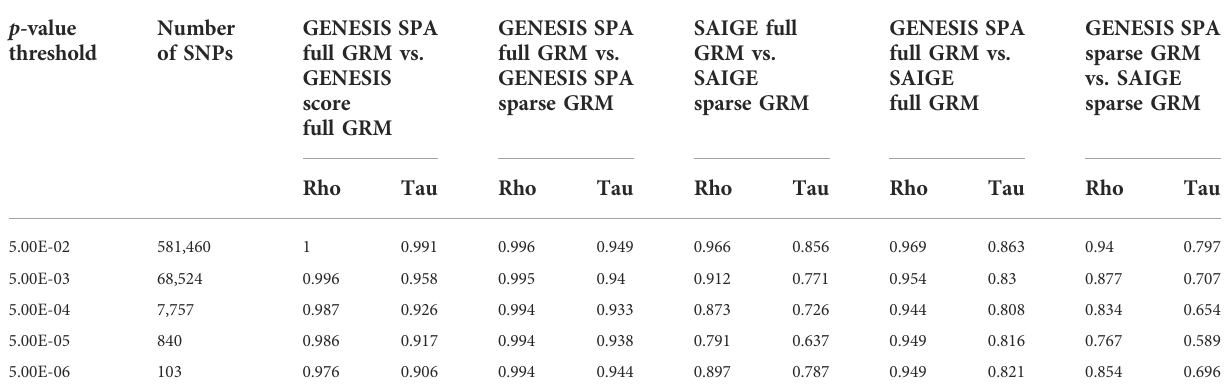
TABLE 3 Correlations of the ranks of the p -values for LLFS WGS